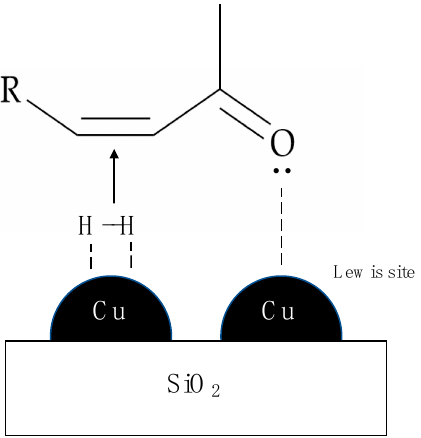
Figure 2. Lewis site role in the double bond hydrogenation of an α , β -unsaturated carbonyl compound.